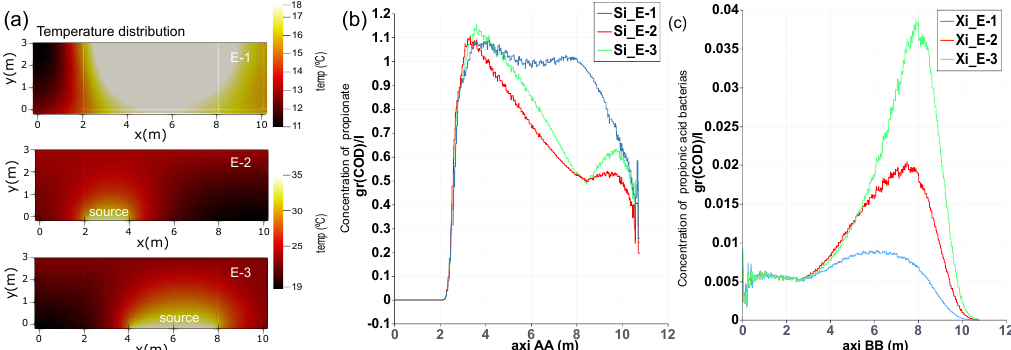
Figure 6. ( a ) Temperature distribution under three different scenarios; E-1 Ambient temperature, E-2 includes a heat source at the bottom of the lagoon, between coordinates 2 and 4, and the E-3 between 4 and 8, in the x axis. ( b , c ) Concentration of propionate and cells, respectively, along the axis AA (see Figure 5) for the different scenarios detailed in ( a ).